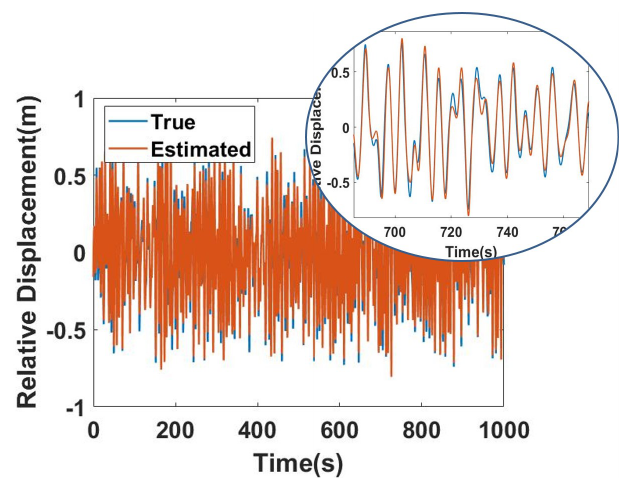
Fig. 8: The estimation of the relative displacement ( z 1 − z 2 ).